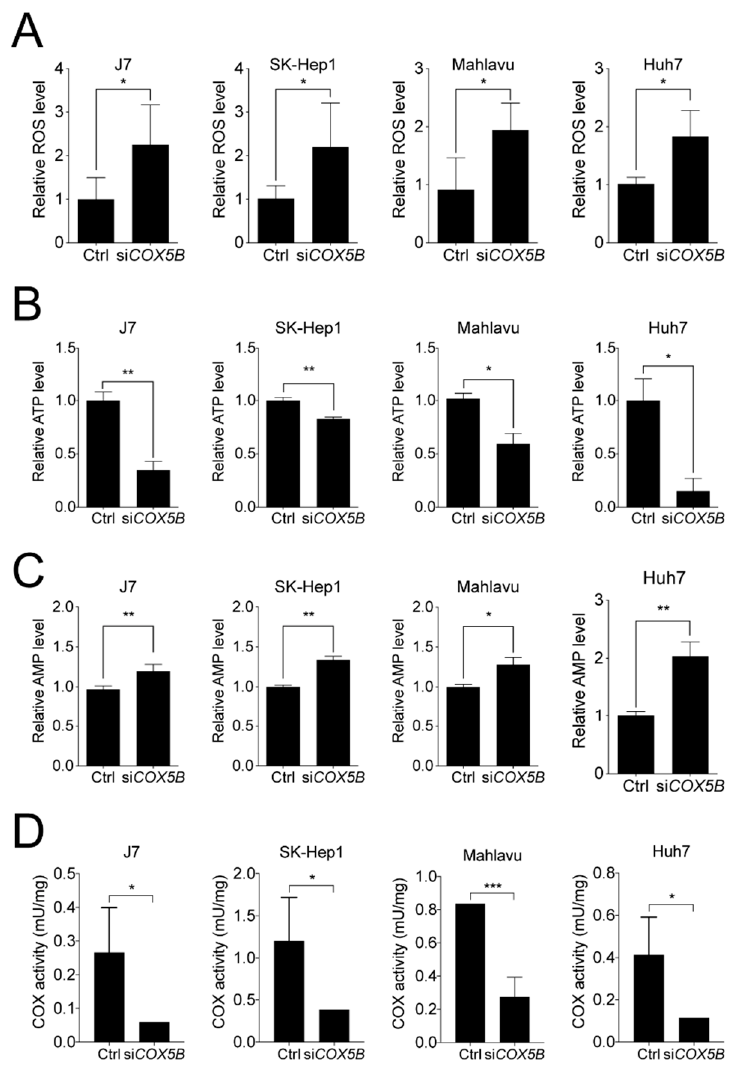
Figure 5. Loss-of-function in COX5B leads to dysfunction of mitochondria and COX. The function of mitochondria was assessed by measuring ( A ) ROS, ( B ) ATP and ( C ) AMP levels with or without COX5B depletion in hepatoma cells. ( D ) The COX activity to oxidize cytochrome c was measured using mitochondria solution isolated from indicated hepatoma cells with or without COX5B silencing. The p value was derived from paired student t -test (two tails). *, p < 0.05; **, p < 0.01; ***, p < 0.001.